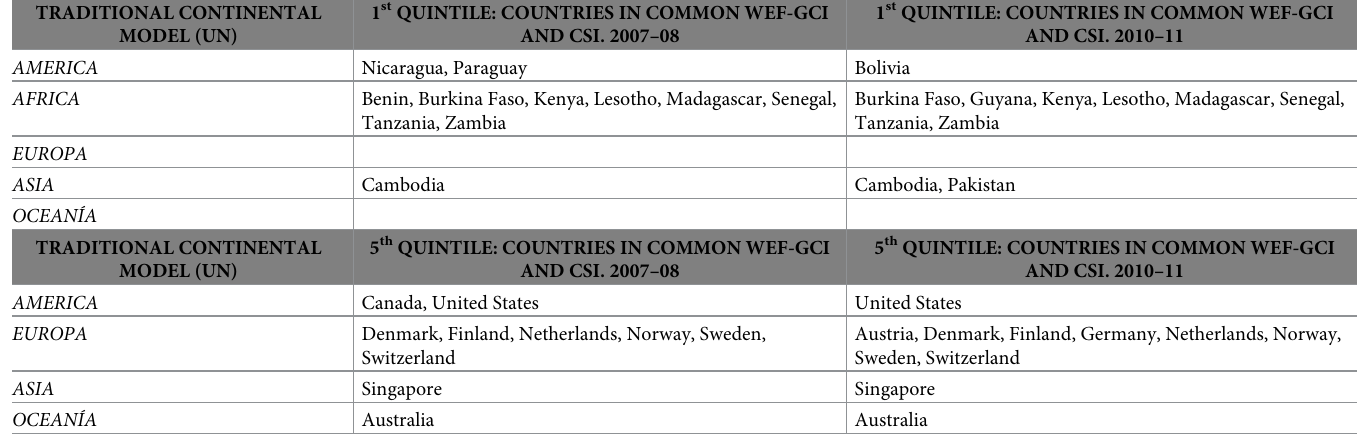
Table 9. Summary of the most and least competitive countries: WEF-GCI versus CSI. TRADITIONAL CONTINENTAL MODEL